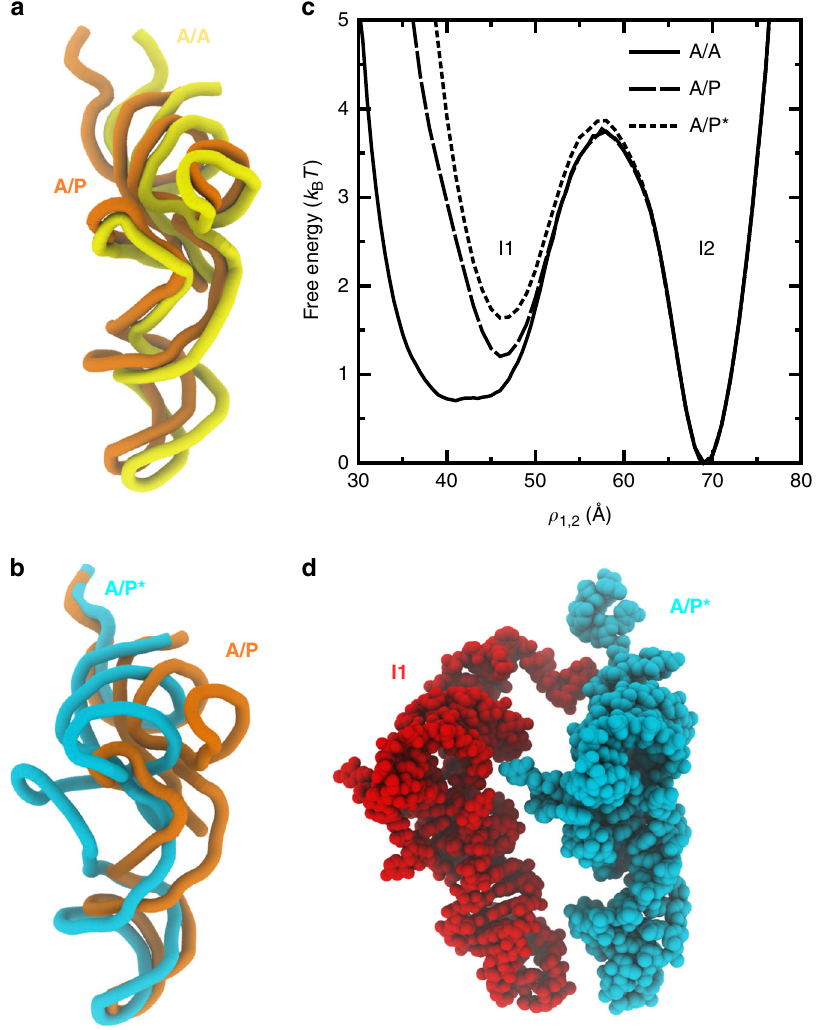
Fig. 6 Intermediates during P/E formation are robust to A-site tRNA position. a Tube representation of A/A (yellow) and A/P (orange; PDB: 4V7C 9 ) tRNA positions. Structures are alignment based on the 23S rRNA atoms. b Tube representation of the A/P and A/P* (light blue; PDB: 4V7D 9 ) structures. c Free-energy pro fi les reveal that the barrier separating the I1 and I2 ensembles is marginally in fl uenced by the A-site tRNA position. d A structural snapshot illustrates how the ribosome can simultaneously accommodate tRNA molecules in the I1 (red) and A/P* (light blue)